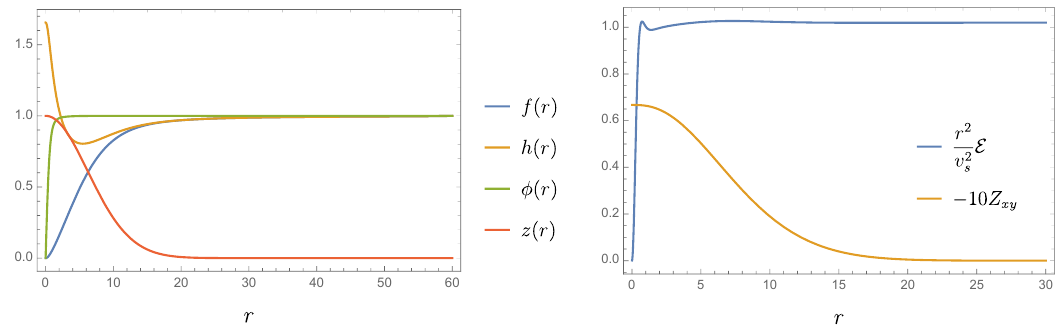
Figure 3 . Numerical solution for the type-B string. We take the same parameters as ones in figure 2. Also we adopt a length unit as v − 1 = 0 . 5 . (left): plots of profile functions. φ ( r ) increases s as φ ∼ v s r for r ∼ 0 while f ( r ) behaves as a quadratic function with respect to r . The three profile functions f, h and φ approach to unity for r → ∞ . The profile function of the Z field, z ( r ) , approaches to zero as r → ∞ starting from unity at r = 0 . (right): plots of energy density (3.26) divided by v 2 /r 2 and the Z -flux density multiplied by − 10 . The energy density has a polynomial s tail like r − 2 like the type-A string. The tension T integrated over 0 ≤ r ≤ 120 v − 1 is 140 . 524 . The s Z -flux density decays exponentially for r → ∞ like the usual Abrikosov-Nielsen-Olesen vortex. The total value of the Z -flux is calculated to − 16 . 9539 , which is consistent with eq.